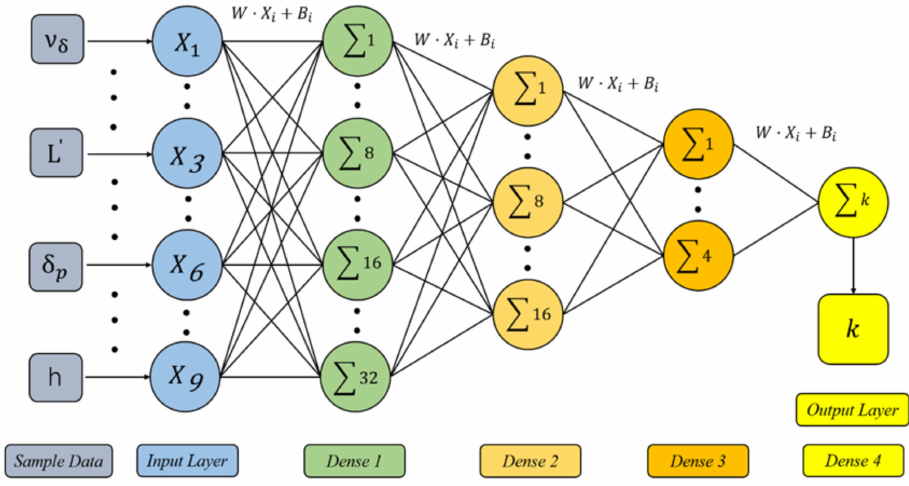
Figure 5. Construction of Keras neural network